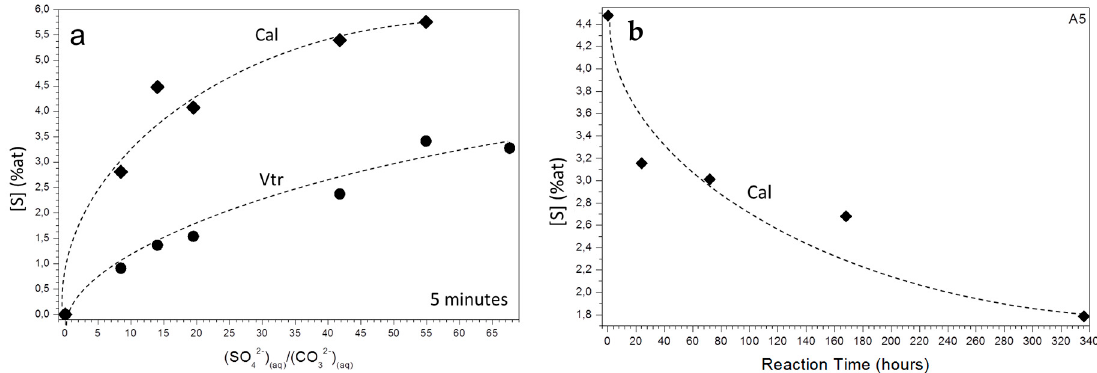
Figure 6. ( a ) The concentration of S (% at) in calcite and vaterite sampled after 5 min of reaction as a function of the initial (SO 42 − )/(CO 32 − ) ratio and ( b ) the variation of [S] (% at) with ageing in calcite crystals sampled from aqueous solutions with a (SO 42 − )/(CO 32 − ) ratio of 14.03 (A5).